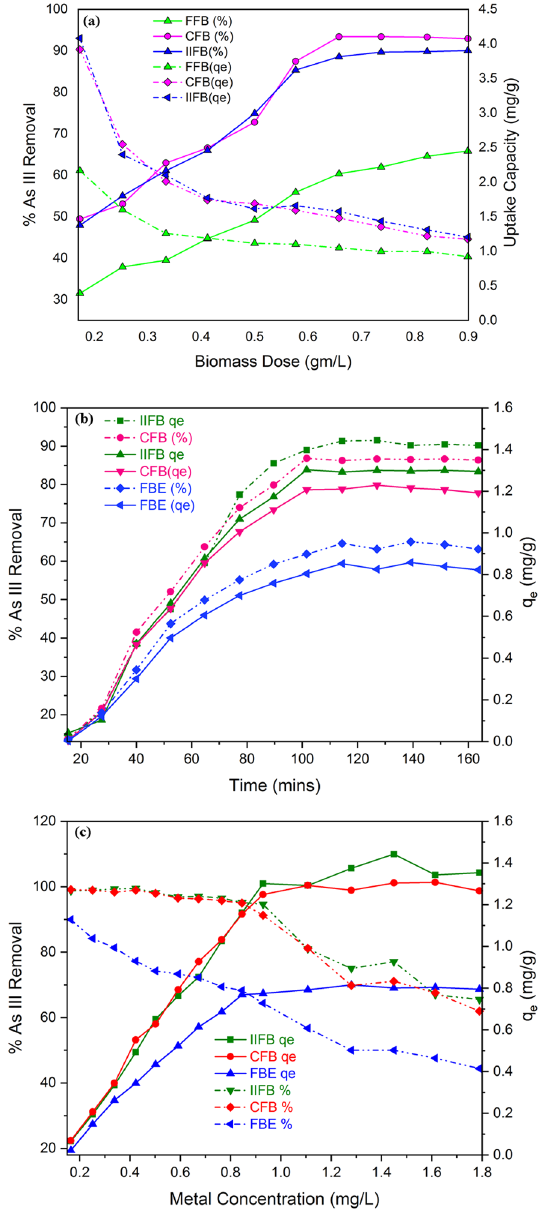
Figure 4. ( a ) Effect of biomass dose on the biosorption of As(III) over FFB, CFB and IIFB. ( b ) Effect of time on As(III) biosorption over FFB, CFB and IIFB. ( c ) Effect of initial metal concentration on As(III) percentage removal and sorption capacity of FFB, CFB and IIFB